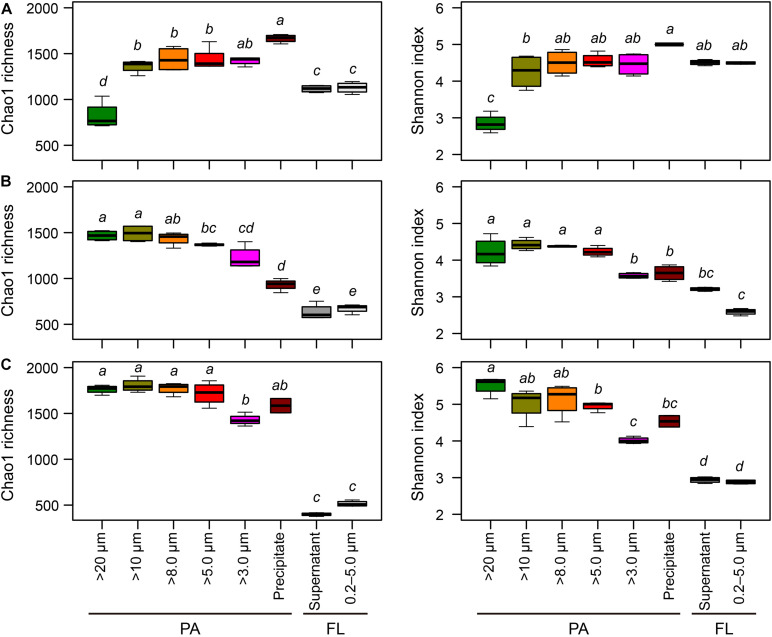
Boxplots of the Chao1 richness and Shannon diversity indices for each sample collection treatment in (A) Lake Taihu, (B) Lake Tianmu, and (C) Lake Fuxian. Diversity indices were calculated using subset of 19,687 sequences per sample. The median values are shown with horizontal black wide lines. Upper and lower edges of the boxes represent the first and third quartile of the distribution of values, with whiskers indicating the lowest and highest values within 1.5 times the interquartile range of the lower and quartiles, respectively. Kruskal–Wallis test was performed to examine the differences among treatments with Holm correction of P-values for multiple comparisons. Different lower-case letters above each boxplot indicate significant differences (P < 0.05) among treatments. PA, particle-attached; FL, free-living.